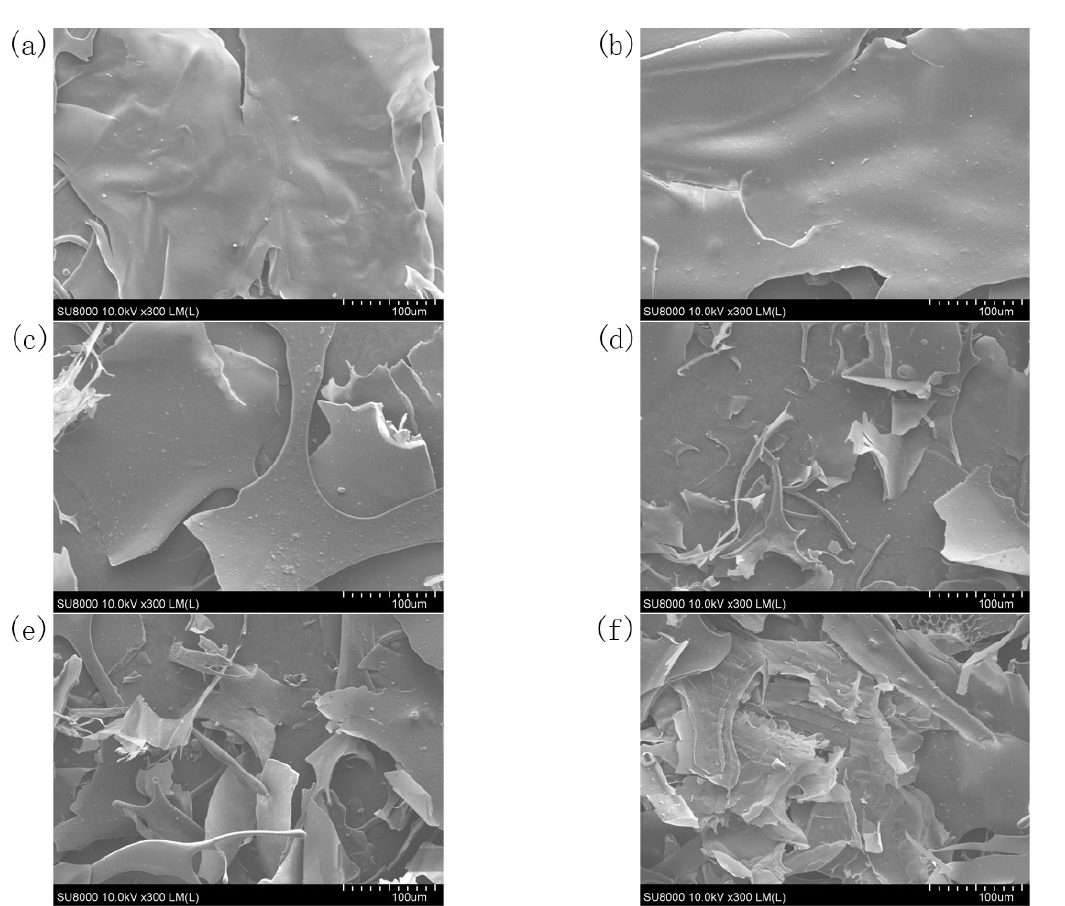
Figure 3. SEM image of native SBP and its ultrasonic degradation products. ( a ) Native, ( b ) 10 min, ( c ) 20 min, ( d ) 30 min, ( e ) 60 min, ( f ) 90 min. ( c ) 20 min, ( d ) 30 min, ( e ) 60 min, ( f ) 90